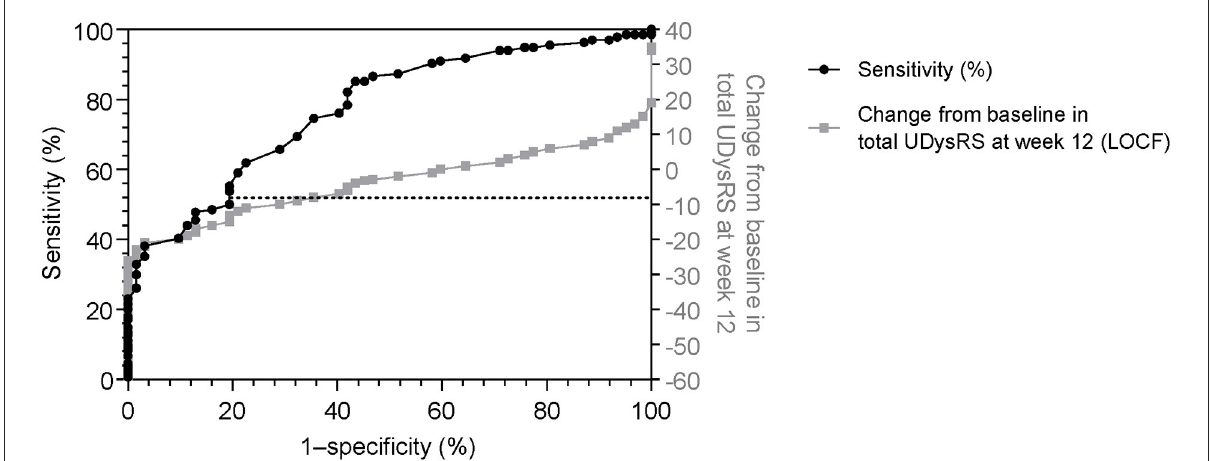
FIGURE2 Receiver operating characteristic curve (sensitivity vs. 1–specificity) for change in the UDysRS total score, using the Movement Disorder Society-Unified Parkinson’s Disease Rating Scale Part IV, item 4.2 ( 1, minimal) as anchor [black line]. Actual change in UDysRS vs 1–specificity ≥ values [gray line] are also shown. 1–specificity values are shown as per the standard for ROC curves. LOCF, last observation carried